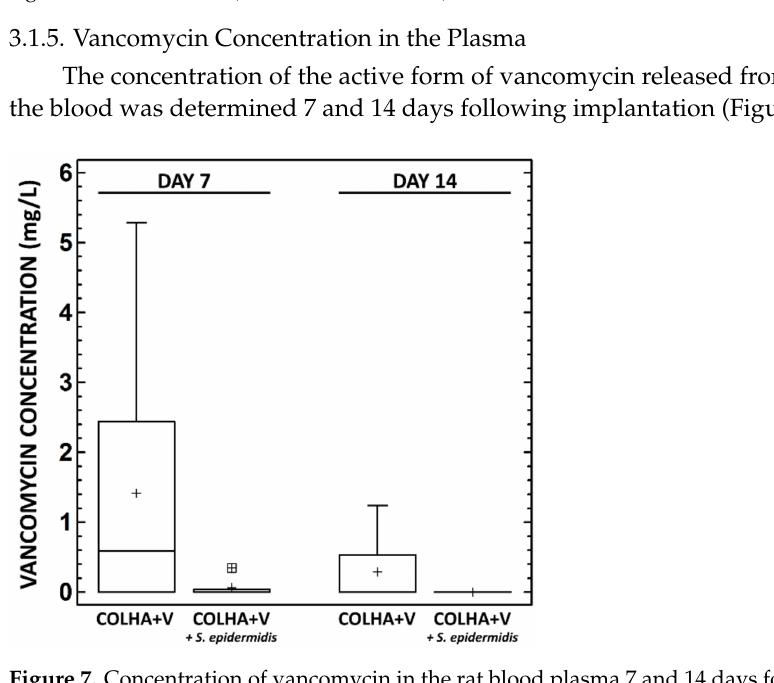
Figure 6. Ca/P weight ratio in the bone tissue of the explanted rat femurs. * Denotes statistically significant differences (0.05, Games–Howell).